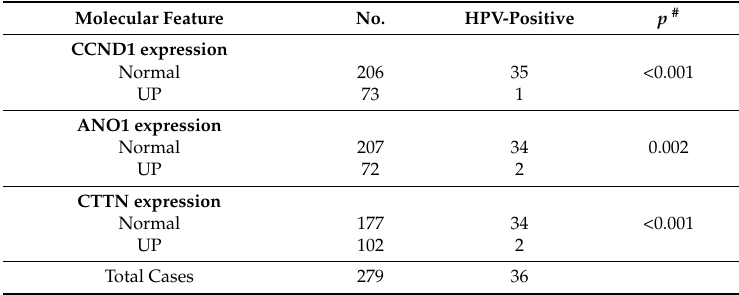
Figure 5. Analysis of CTTN , CCND1 and ANO1 gene amplification and mRNA expression in the TCGA cohort of 530 HNSCC patients using cBioPortal. Schematic representation showing the percentage of cases with amplification or mRNA upregulation of each gene. Kaplan–Meier survival curves categorized by CTTN , CCND1 and ANO1 gene amplification dichotomized as positive versus negative; CTTN, CCND1 and ANO1 mRNA expression (RNA seq V2 RSEM, z -score threshold ±2) dichotomized as normal versus upregulation (UP); p values estimated using the Log-rank test. Table 3. Analysis of CCND1 , ANO1 , and CTTN mRNA expression in relation to HPV status in 279 HNSCC TGCA patients.